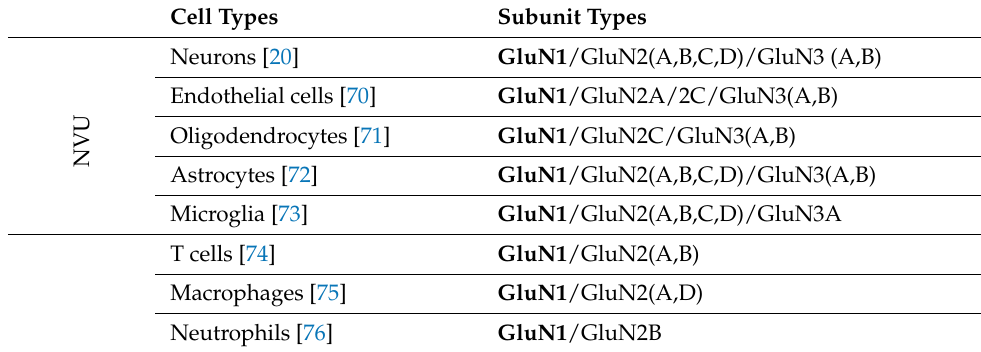
Table 2. NMDAR subtypes in resident and CNS infiltrating